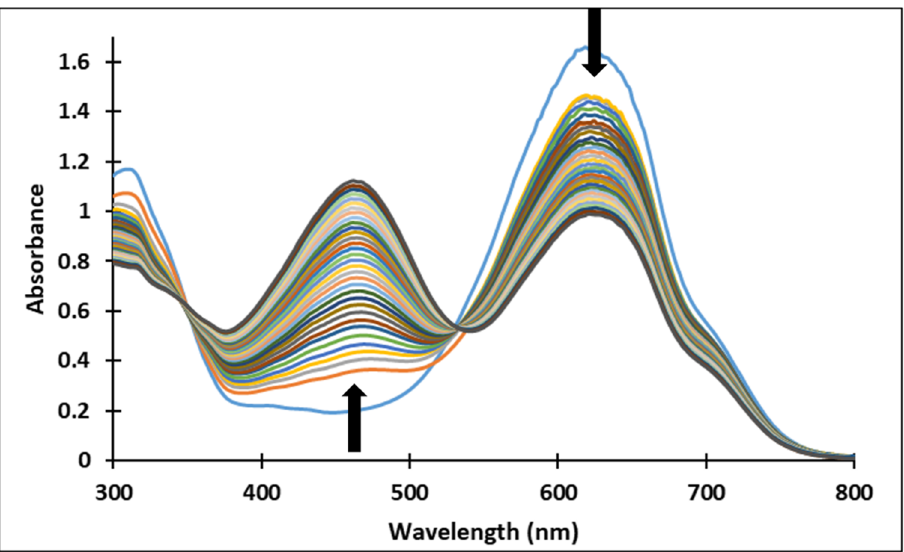
Figure 10. Spectral variations after direct pH-jump of solution of compound 4 , from pH 2.09 to pH 9.72.